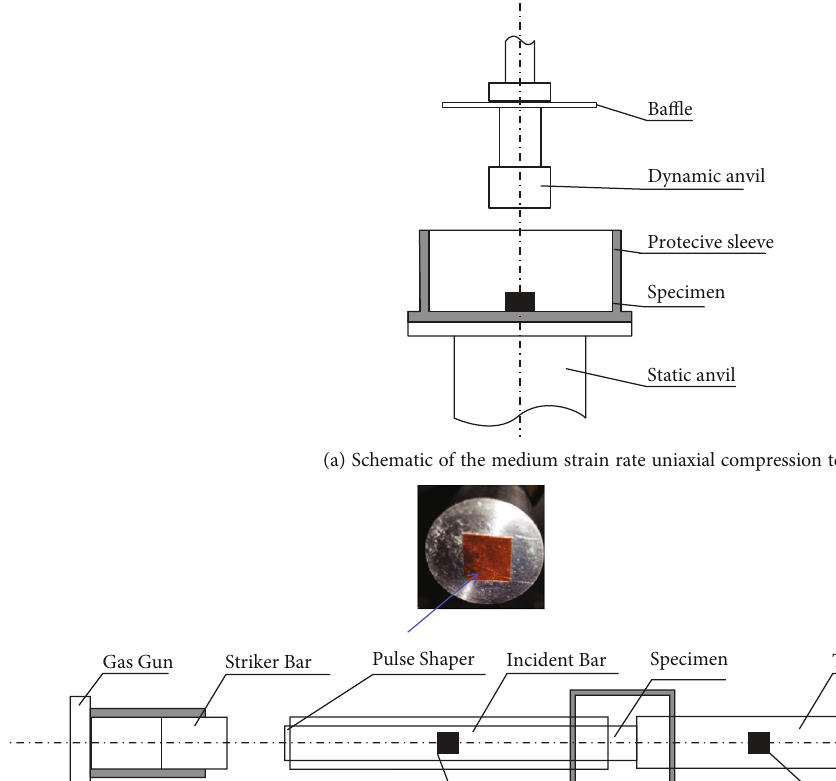
Figure 1: Specimen for the uniaxial compression test.